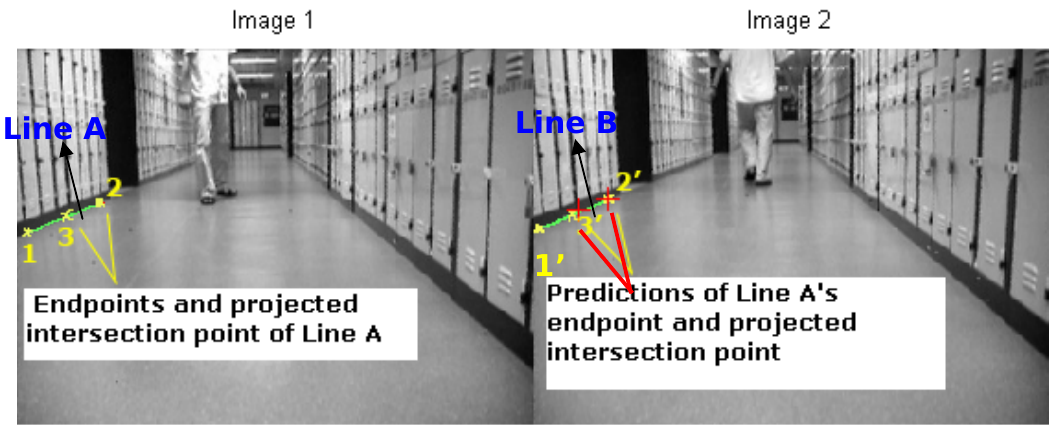
Figure 8. The endpoints and projected intersection point of the lines in the stored and captured images. The image 1 (on the left) is captured at the 57th sample time and the right one (image 2) is at the 58th sample